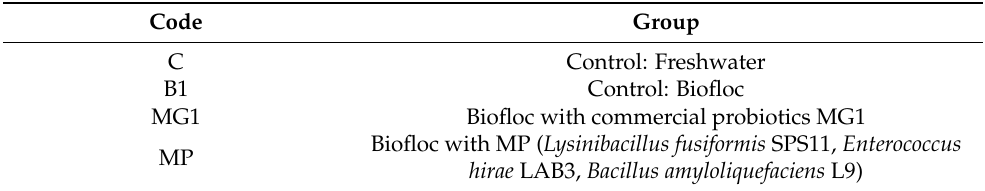
(Table 1). All the groups were set up in triplicates. For the biofloc groups with probiotics, MG1 and MP were inoculated at the concentration of 5 × 10 8 CFU mL − 1 . Table 1. Experimental groups of probiotic addition in tilapia biofloc